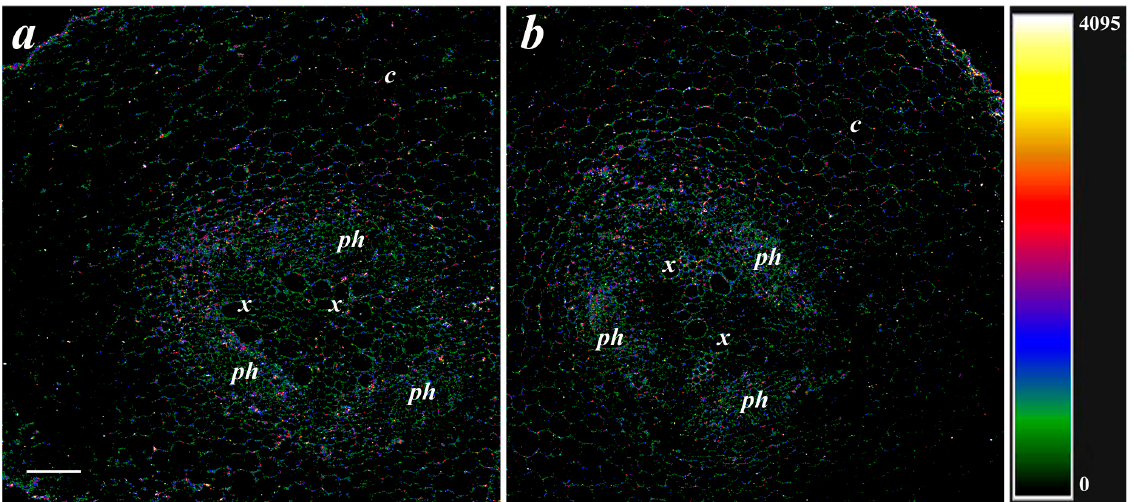
Figure 4. Immunolocalization of the ABA on cross-sections from basal part of pea roots untreated ( a ) and treated with Pseudomonas mandelii IB-Ki14 ( b ). The heatmap shows color-coded intensity of the fluorescence signal. The scale bar is 100 μ m. x —xylem; ph —phloem; c —cortex.